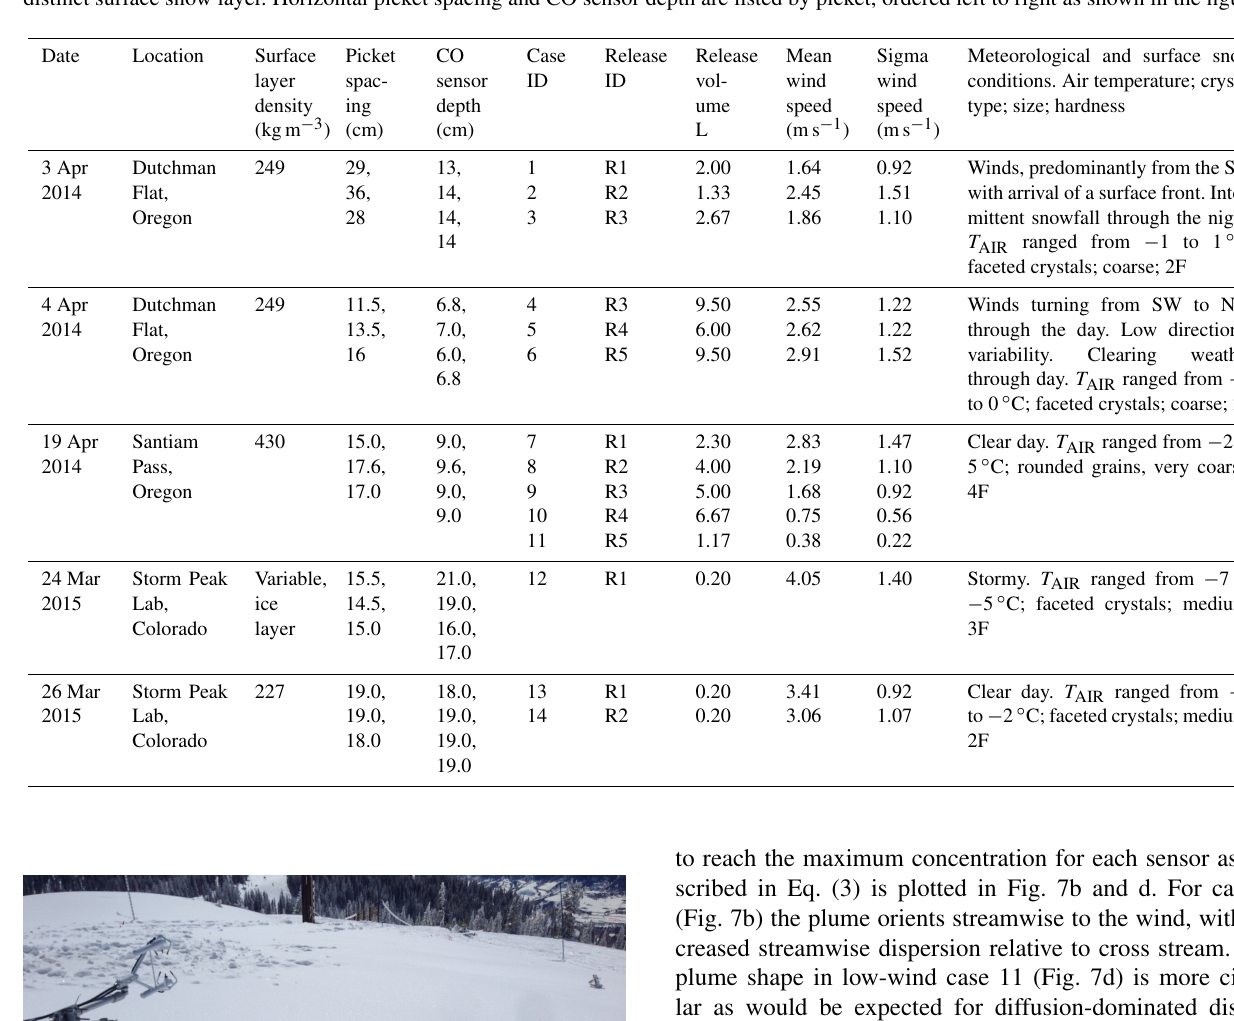
Table 1. Summary of cases used for this analysis. Wind speed is at 1m nominal height. Layer density is the average snow density for a distinct surface snow layer. Horizontal picket spacing and CO sensor depth are listed by picket, ordered left to right as shown in the figures.